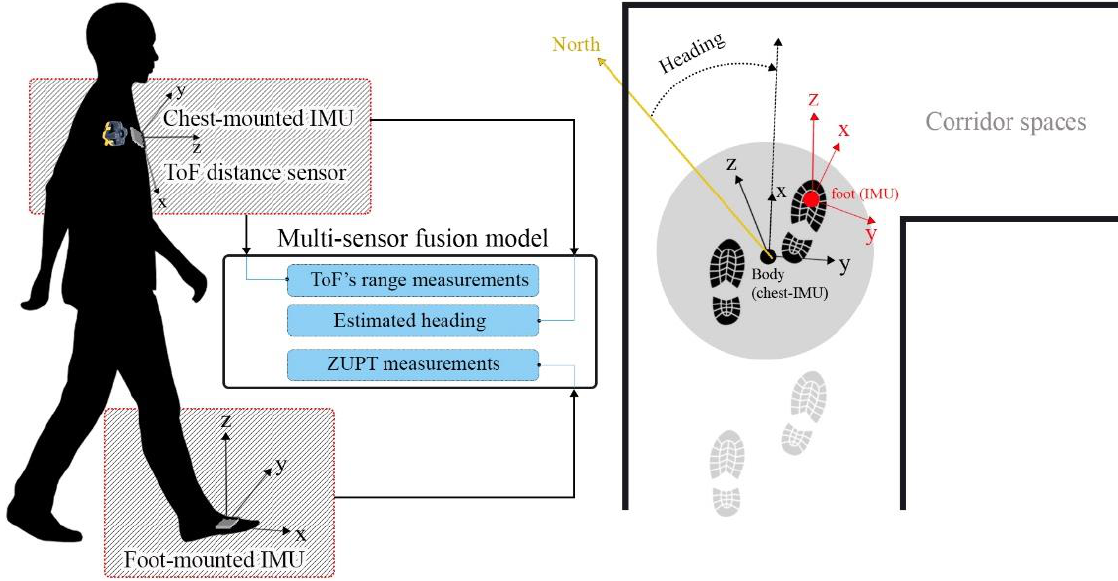
Figure 1. Visual description of installed sensors on the human body, fusion parameters, measurements and orientation of body and sensors.